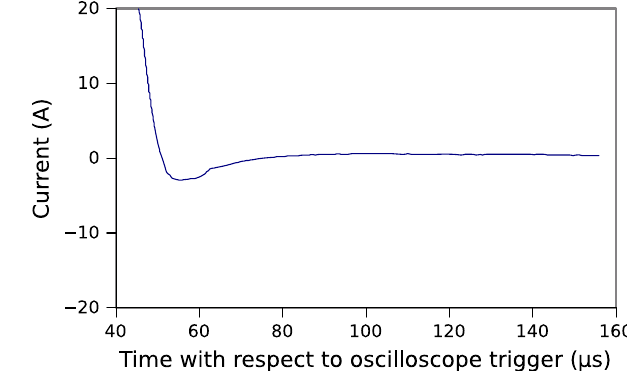
FIG. 11. Measured postpulse current following 250 A flat-top magnet current, without saturating inductors but with SF5408 fast recovery diodes, in a series/parallel arrangement, connected in series with diode D2.